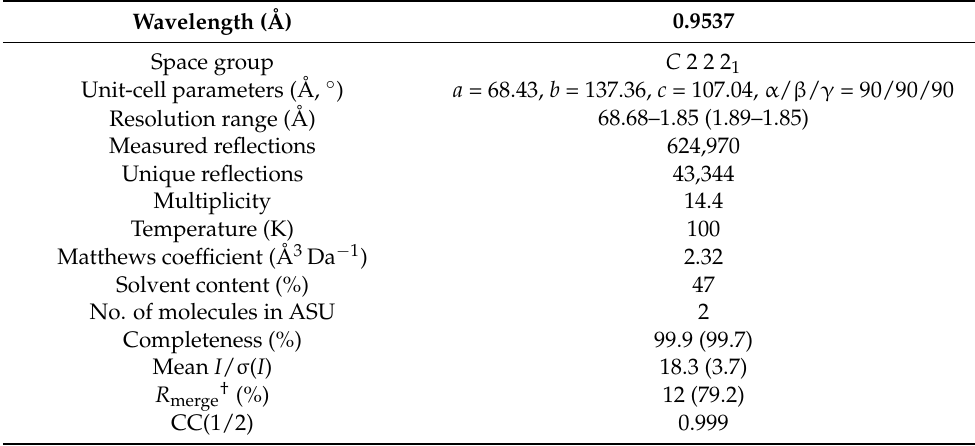
Table 1. Data collection and refinement statistics for NTR